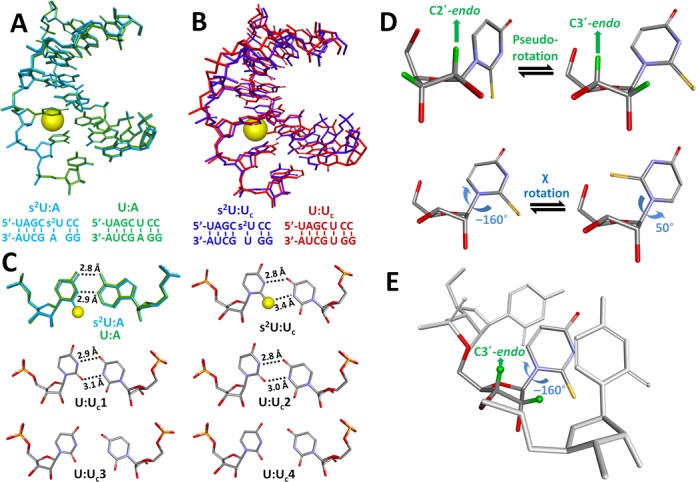
Crystal structures, sequences and structural features of the RNA duplexes investigated here; (A) Structural comparison of s2U:A (red, PDB ID: 4U34) and U:A (blue, PDB ID: 4U37), RMSD is < 0.2 Å; (B) Structural comparison of s2U:Uc (light blue, PDB ID: 4U35) and U:Uc1 (pink, PDB ID: 4U38), the most structurally similar duplex from U:Uc, RMSD is 1.3 Å. Sulfur atoms are displayed as yellow spheres scaled to their van der Waals radii; (C) A comparison of H-bond geometries of base pairs at the site of s2U-substitution. The geometries for s2U:A and U:A overlap well and the geometry for s2U:Uc is most similar to that of U:Uc1; (D) Pseudorotation phase angle (P) and chi torsion angle (χ) rotation of a representative s2U nucleotide; (E) s2U nucleotide in PDB ID: 4U34 adopting the C3′-endo sugar pucker and a χ value of –160°. These values are normally found in structured RNA as they maximize base–base stacking and minimize strain and clashes.